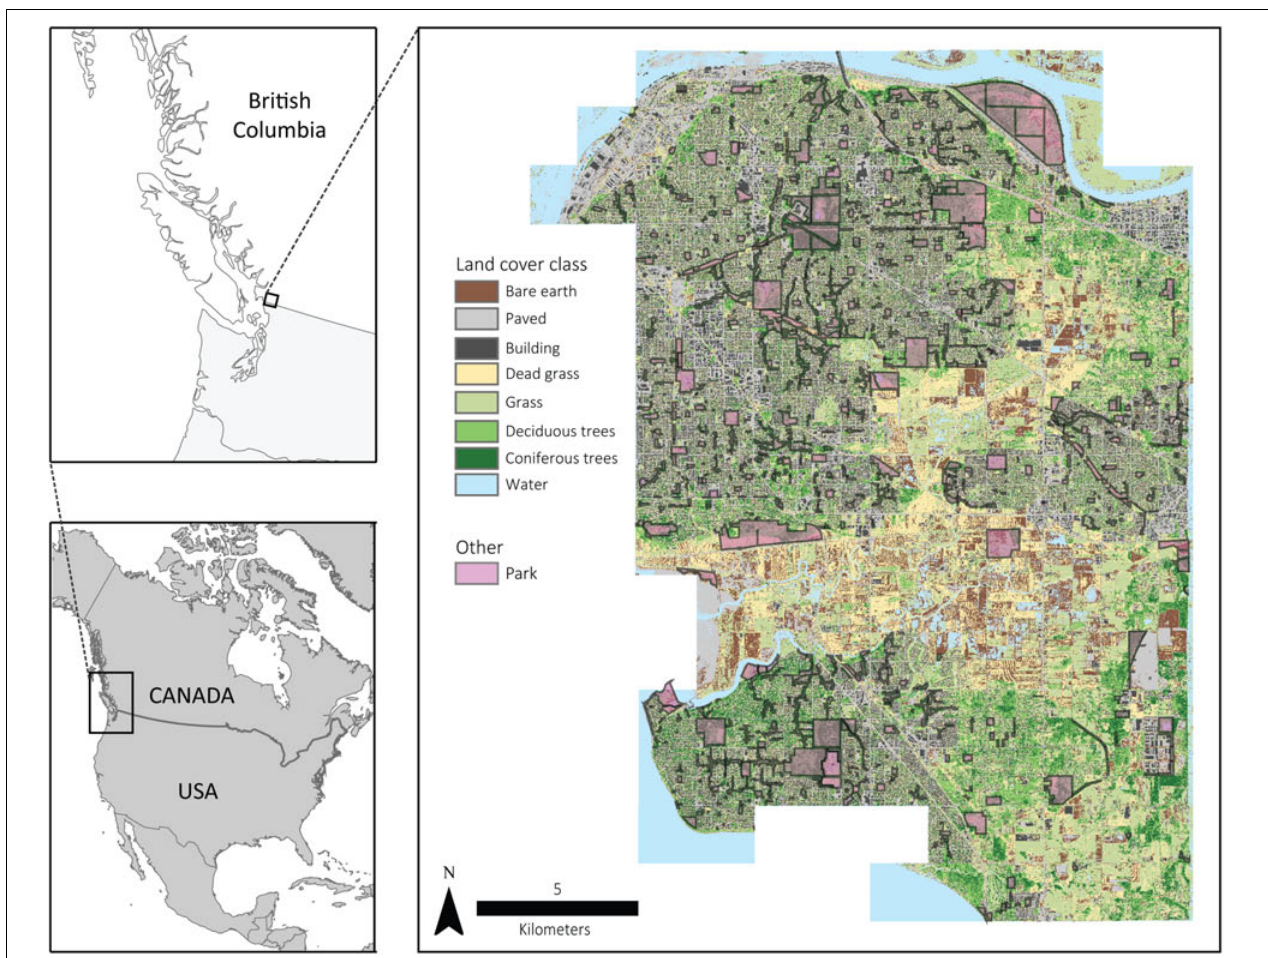
FIGURE 2 | Entirety and location of the Surrey, BC, Canada, the land cover classification from Plowright et al. (in review) and the municipal parks system across the